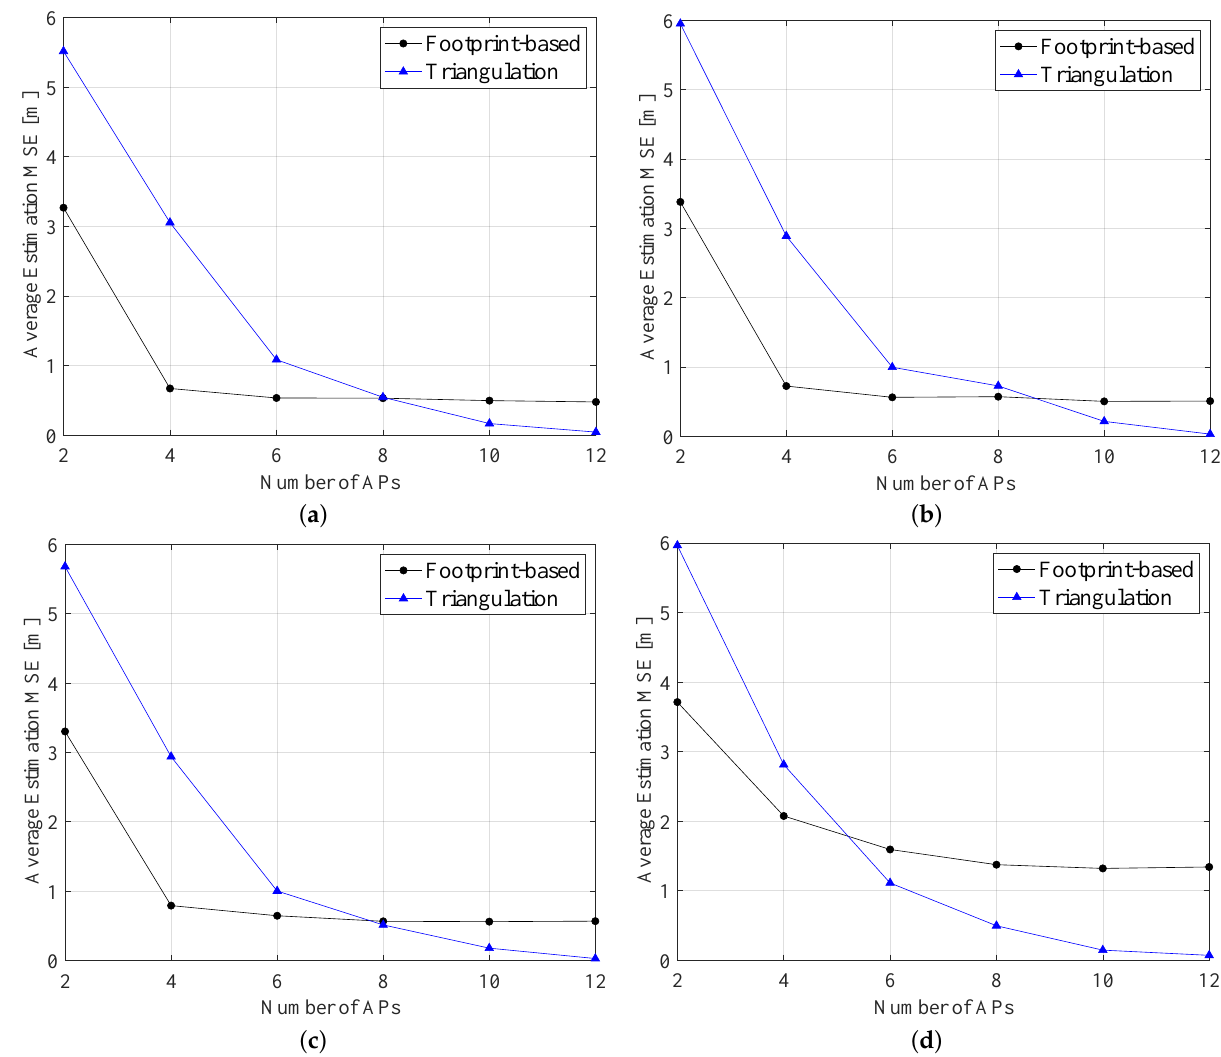
Figure 7. Average MSE comparison of fingerprint to triangulation approaches versus the number of APs and for different water types, i.e., ( a ) pure, ( b ) clear, ( c ) coastal and ( d ) harbor water. We assume a beam angle of 60 ◦